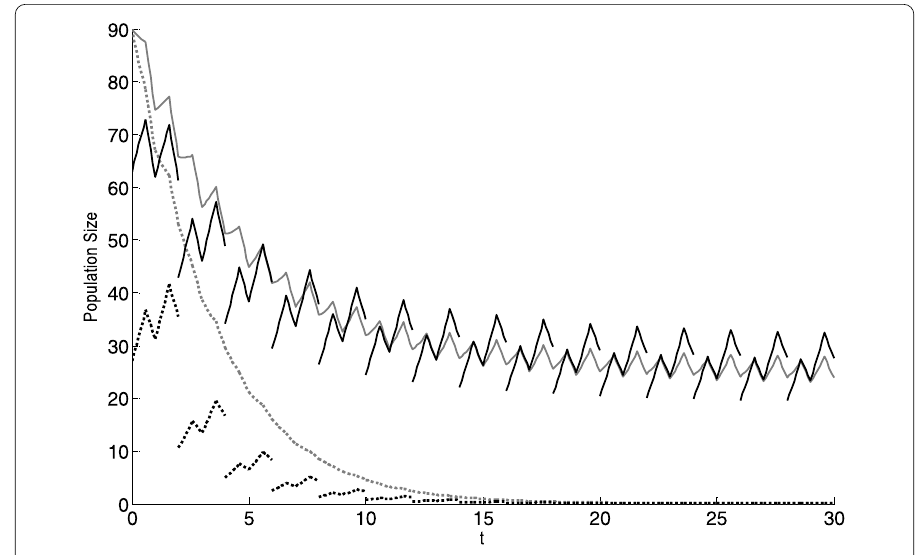
Figure 2 The dynamics of rodent population in model (7) and